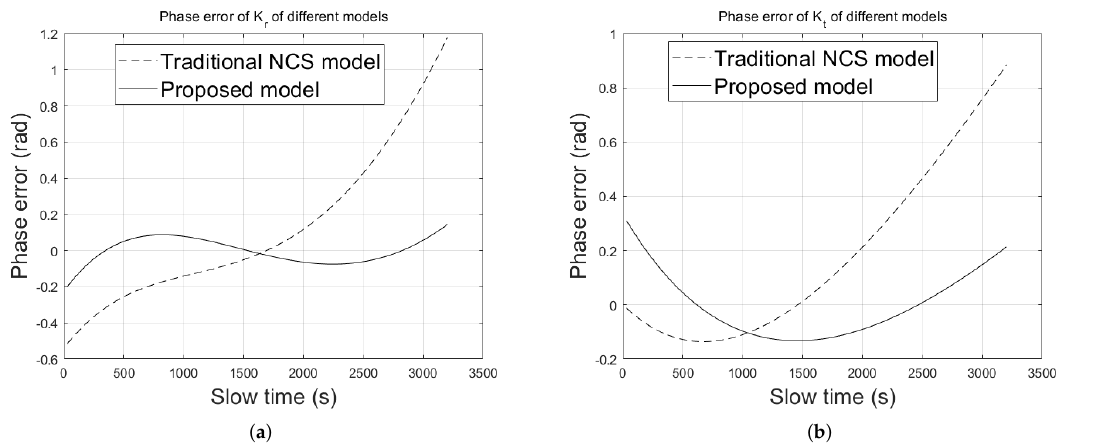
Figure 8. Residual phase error after cross-range spatial variation modeling. ( a ) Phase error of K r of different models. ( b ) Phase error of K t of different